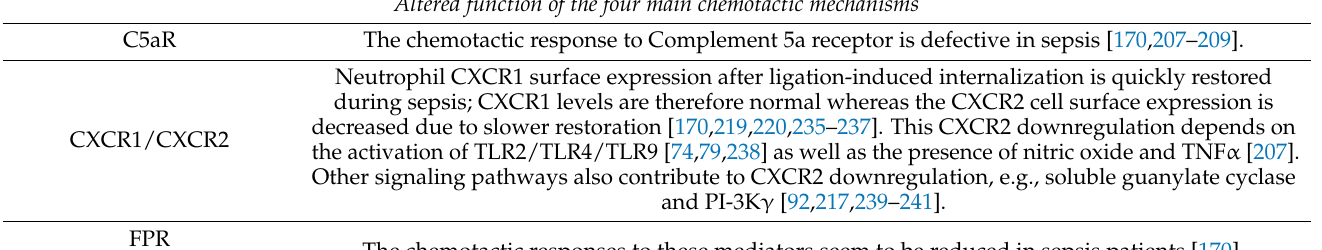
Table 2. The modulation of neutrophil receptors during sepsis; a summary of important effects on neutrophil